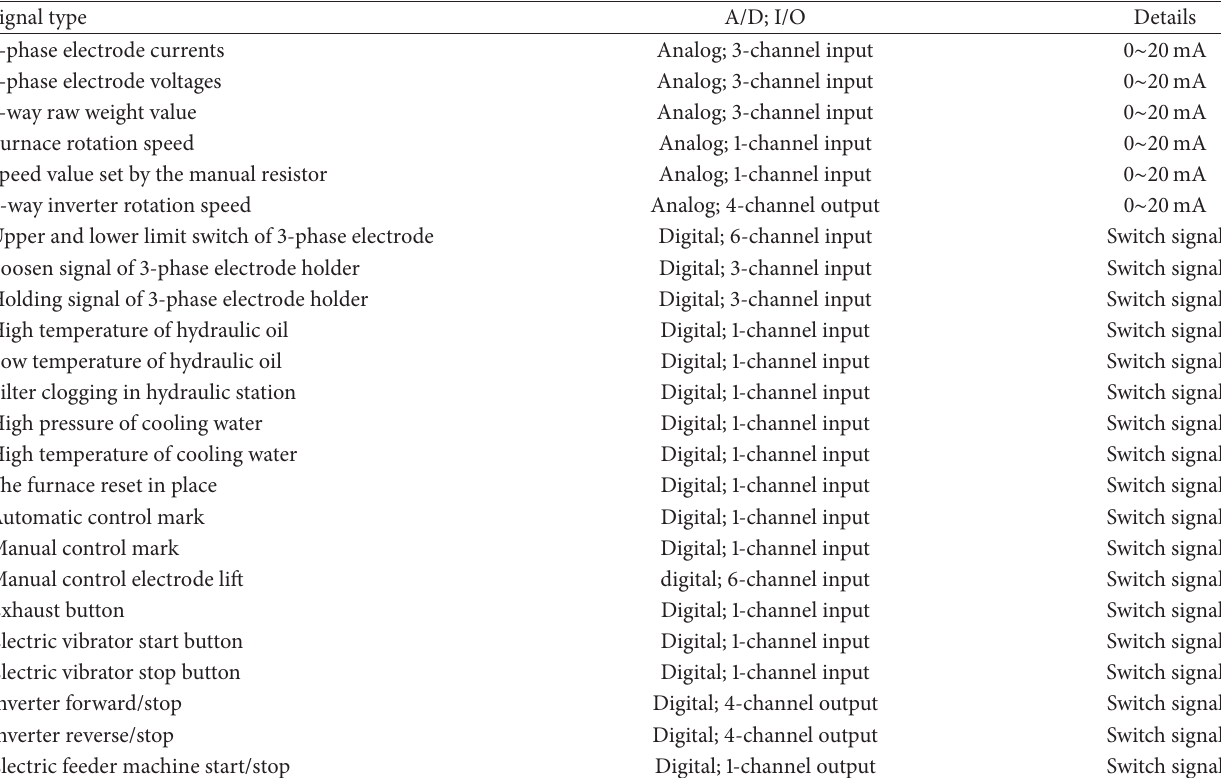
Table 1: Inputs and outputs of the